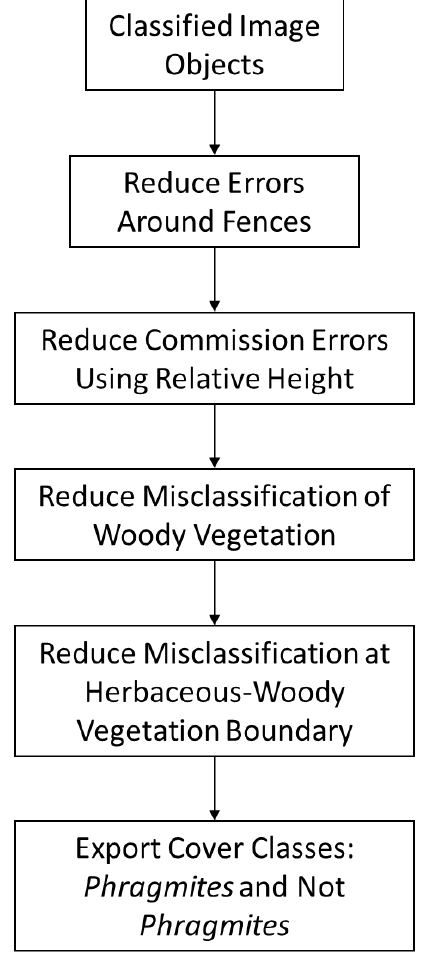
Figure 5. Flowchart detailing the post-ML OBIA workflow in eCognition. The workflow begins by loading in the image objects classified by a machine learning algorithm, reduces classification error between vegetation types, and then exports the Phragmites and Not Phragmites cover classes.